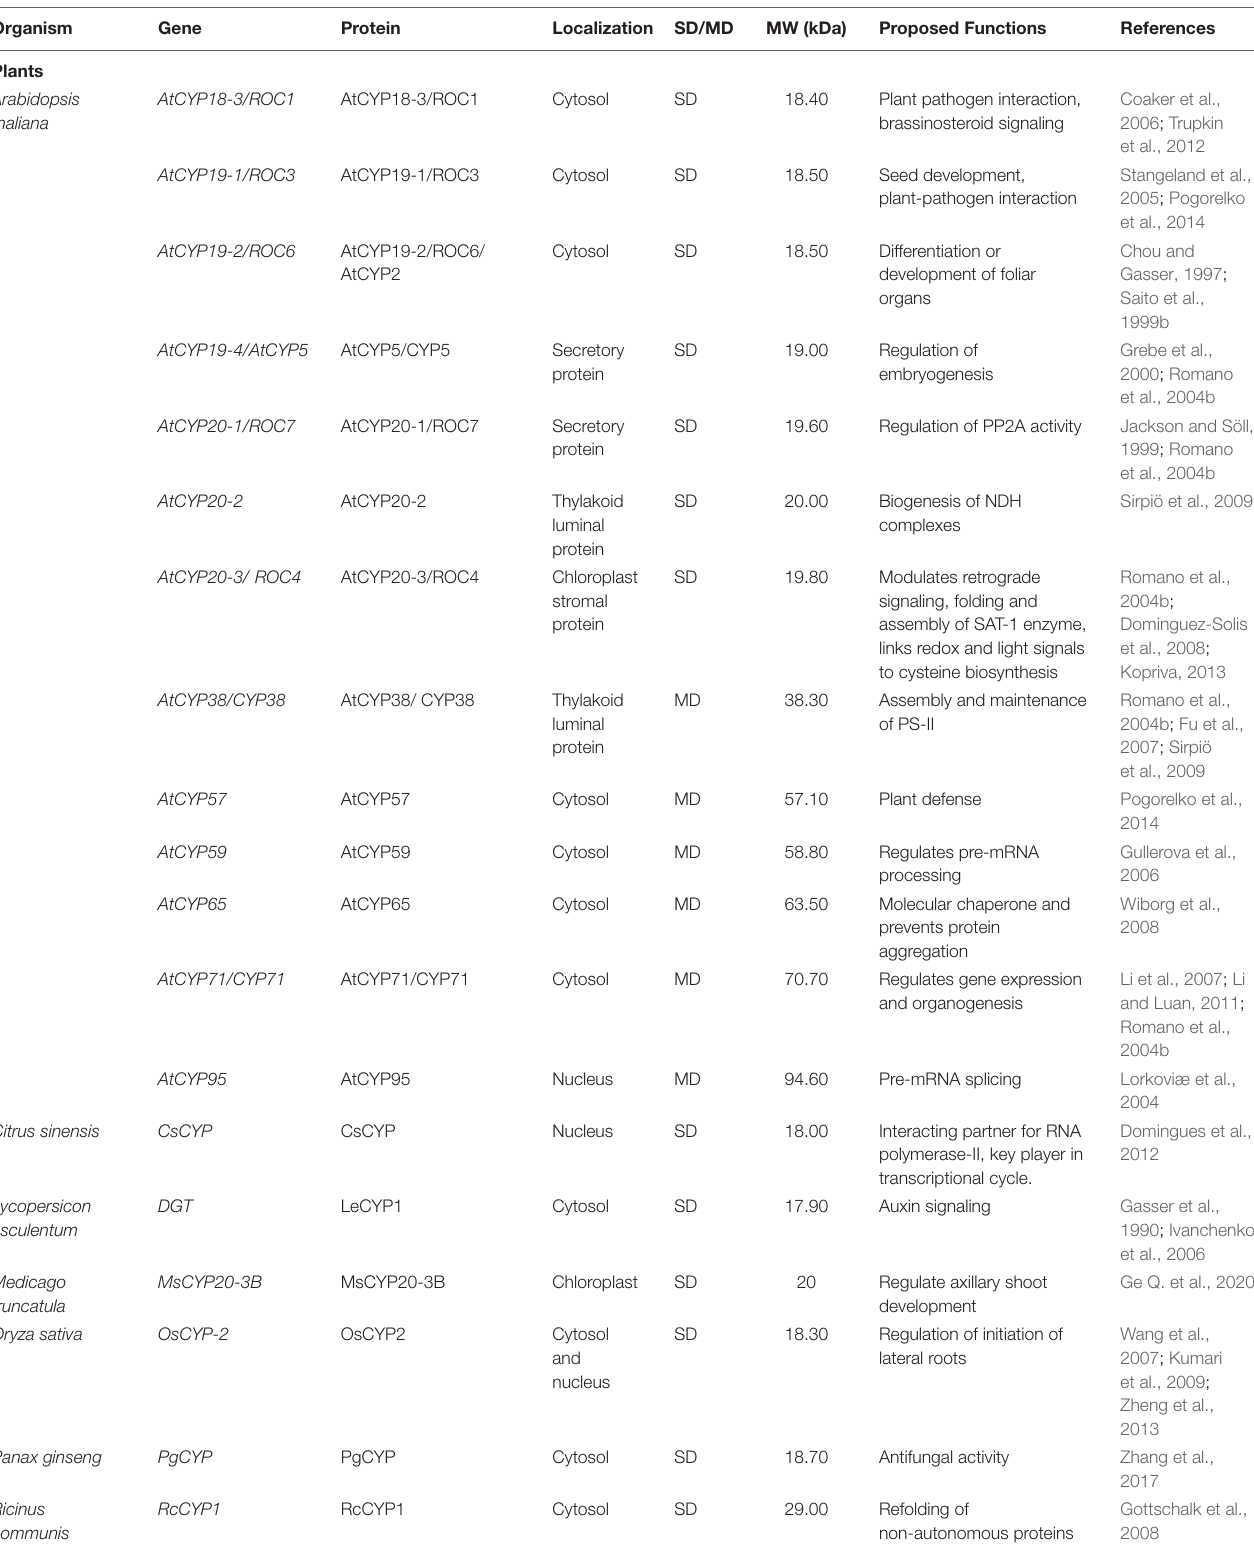
TABLE 2 | Cellular functions of cyclophilins in different organisms.